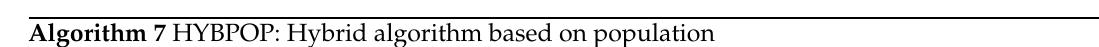
Algorithm 7 HYBPOP: Hybrid algorithm based on